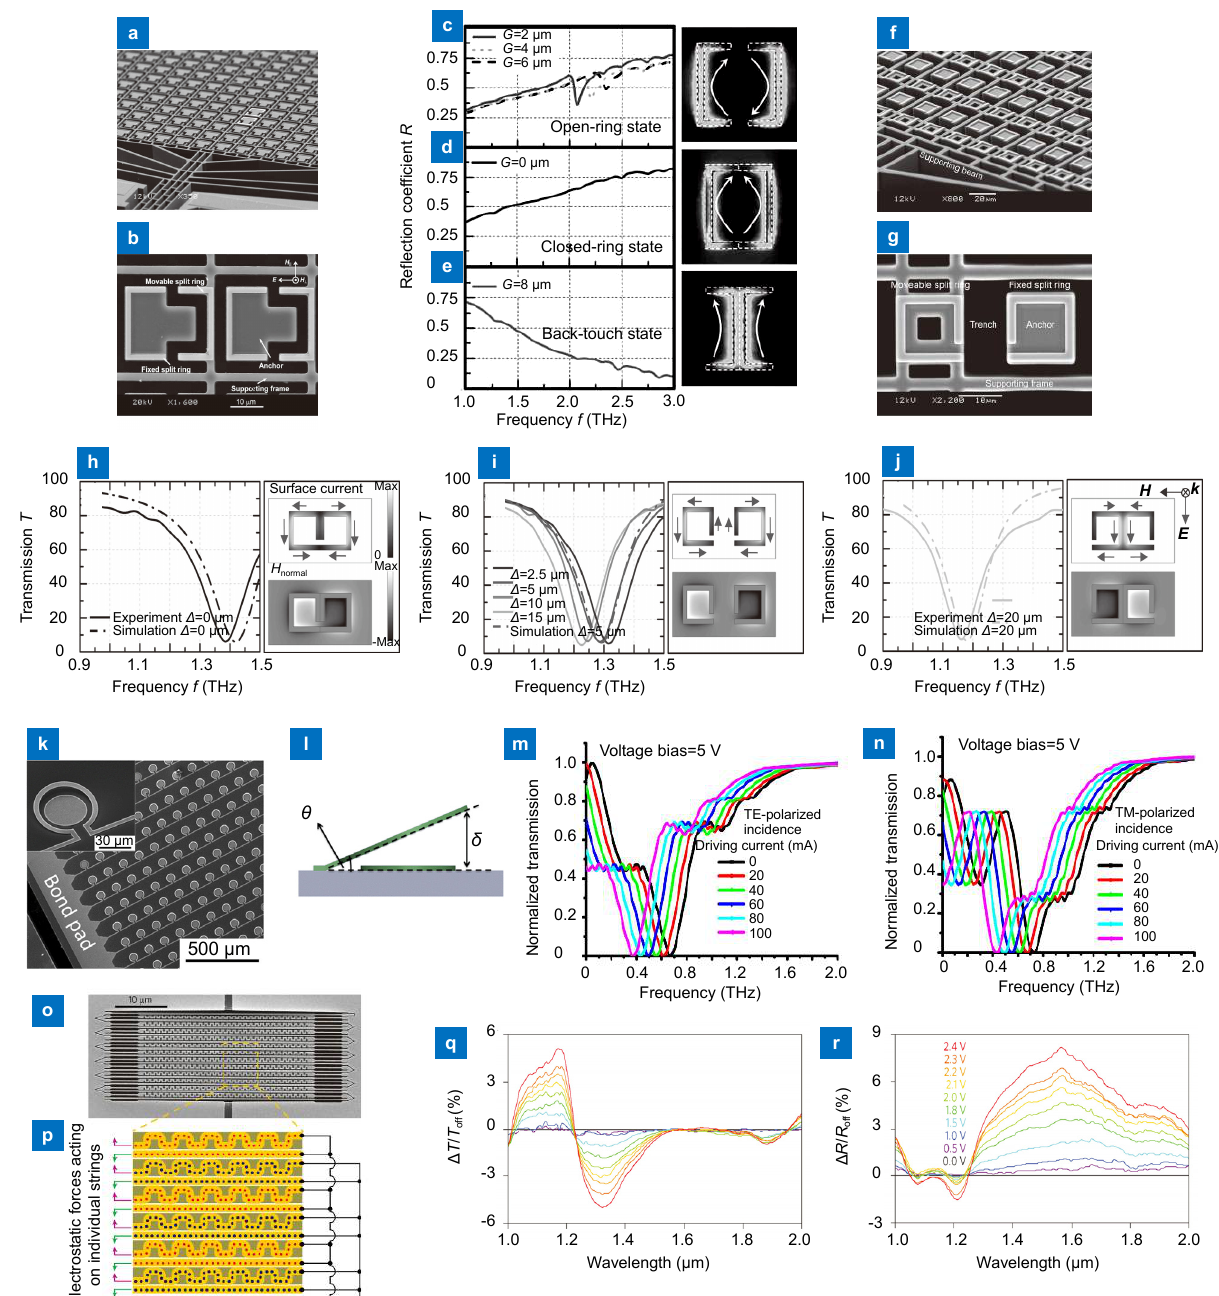
Fig. 15 | Reconfigurable metamaterials using M-NEMS . SEM image of ( a ) the metamaterial molecule array with micro-machined actuators and ( b ) the close-up top view of the unit cell. The measured reflection coefficient of the metamaterial under the TE polarized incidence in ( c ) the open-ring state ( G= 2 μ m, 4 μ m, and 6 μ m), ( d ) the closed-ring state, and ( e ) the back-touch state (The simulation results of the induced surface currents by the magnetic response is shown on the right side of each figure). SEM image of ( f ) the metamaterial molecule array with micro-machined actuators and ( g ) the close-up top view of the unit cell. The simulated and measured transmission spectra for the TM polarization incident wave at ( h ) Δ = 0, ( i ) Δ = 2.5, 5, 10, 15 μ m (from dark to light), and ( j ) Δ = 20 μ m. The simulated surface currents and normal magnetic field components are shown on the right side of each figure. ( k ) SEM image of the fabricated metamaterial (the zoom-in image of the omega-ring design is shown in the inset), ( l ) Cross-sectional view of released omega-ring showing the angle of curvature ( θ ) and bending height ( δ ). ( m ) and ( n ) Measured transmission spectra of Omega-ring metamaterial in the TE-polarized and TM-polarized incidence when the voltage bias is 5 V, respectively. ( o ) SEM image of the reconfigurable plasmonic metamaterial. ( p ) Schematic of the driving circuit (black) and a section of the metamaterial pattern consisting of a gold nanostructure (yellow) supported by silicon nitride strings (brown). ( q ) Transmission and ( r ) reflection spectra of the metamaterial for different static voltages. Figure reproduced from: ( a – e ) ref. 76 , John Wiley and Sons; ( f – j ) ref. 74 , John Wiley and Sons; ( k – n ) ref. 77 , AIP Publishing; ( o – r ) ref. 48 , Springer